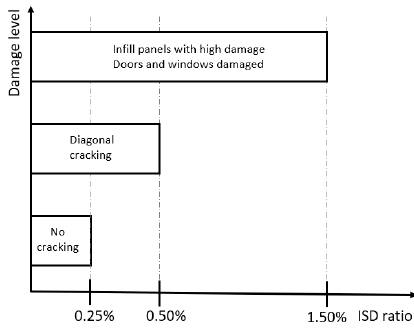
Figure 16. Relationship between maximum ISD ratio and infill masonry damage level proposed by